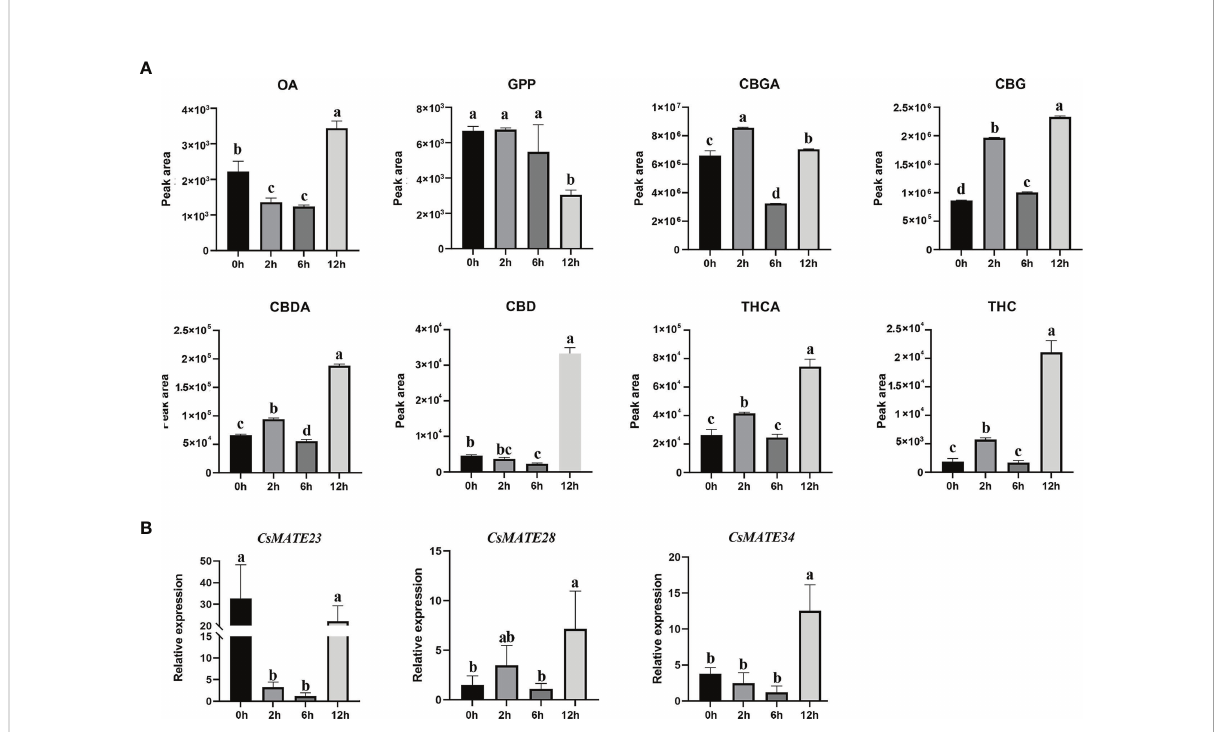
FIGURE 6 Cannabinoids contents (A) and expression of CsMATE23 , CsMATE38 and CsMATE34 under UV-B light (B) . Leaves from UV-B treated three- weeks-old C. sativa seedlings were collected at 0, 2, 6 and 12 hours. Cannabinoids contents were measured using QQQ MS/MS. gene expressions were detected by qRT-PCR with CsEF1-alpha as internal reference. Three biological repeats were performed. Different letters above the bars indicate signi fi cantly different values ( p < 0.05) calculated using one-way analysis of variance (ANOVA) followed by Tukey ’ s multiple range